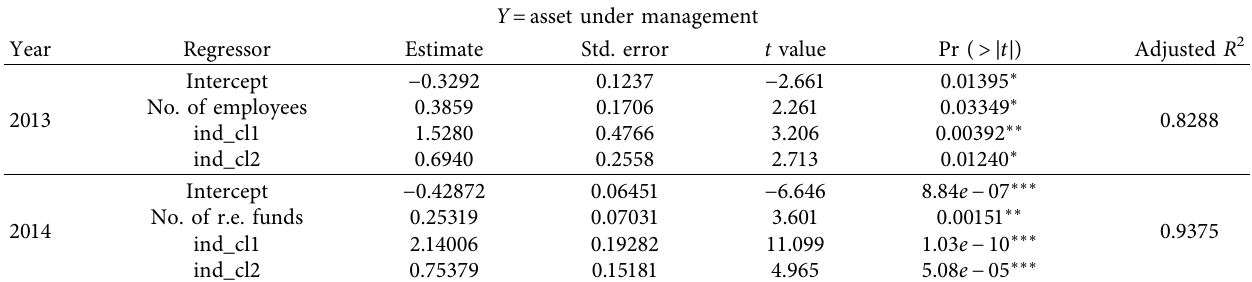
Table 8: Coefficients resulting from the first regression on clustered